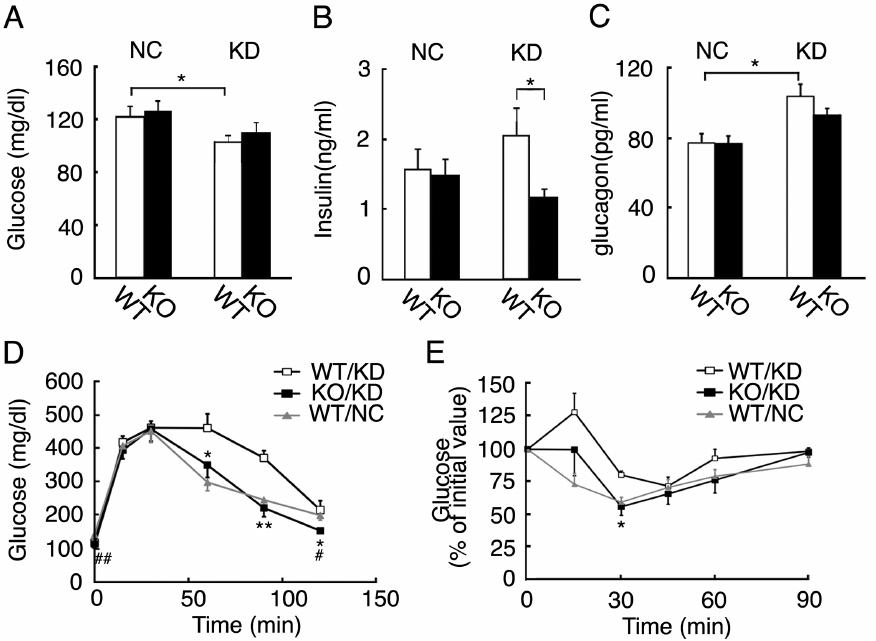
Figure 6. Glucose tolerance and insulin tolerance tests of wild-type and Fgf21 knockout mice. (A–C) Blood glucose, insulin, and glucagon levels of 3-month-old wild-type (WT) and Fgf21 knockout (KO) mice fed NC or KD for 6 days (n=8–12 mice per group; *, P , 0.05). (D) A glucose tolerance test (GTT) of 3-month-old wild-type (WT) and Fgf21 knockout (KO) mice fed KD for 6 days (n=6–10 per group; *, P , 0.05; **, P , 0.01 vs. wild-type mice fed KD at the same timepoint, # , P , 0.05; P , 0.01 vs. wild-type mice fed NC at the same timepoint). (E) An insulin tolerance test of wild-type (WT) mice fed NC or KD and Fgf21 knockout (KO) mice fed KD for 6 days (n=4–7 per group; *, P , 0.05 vs. wild-type mice fed KD at the same timepoint).